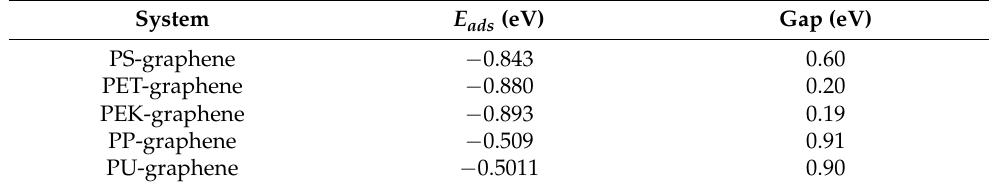
Table 1. Adsorption energies and HOMO-LUMO gap for the polymer-graphene systems. System